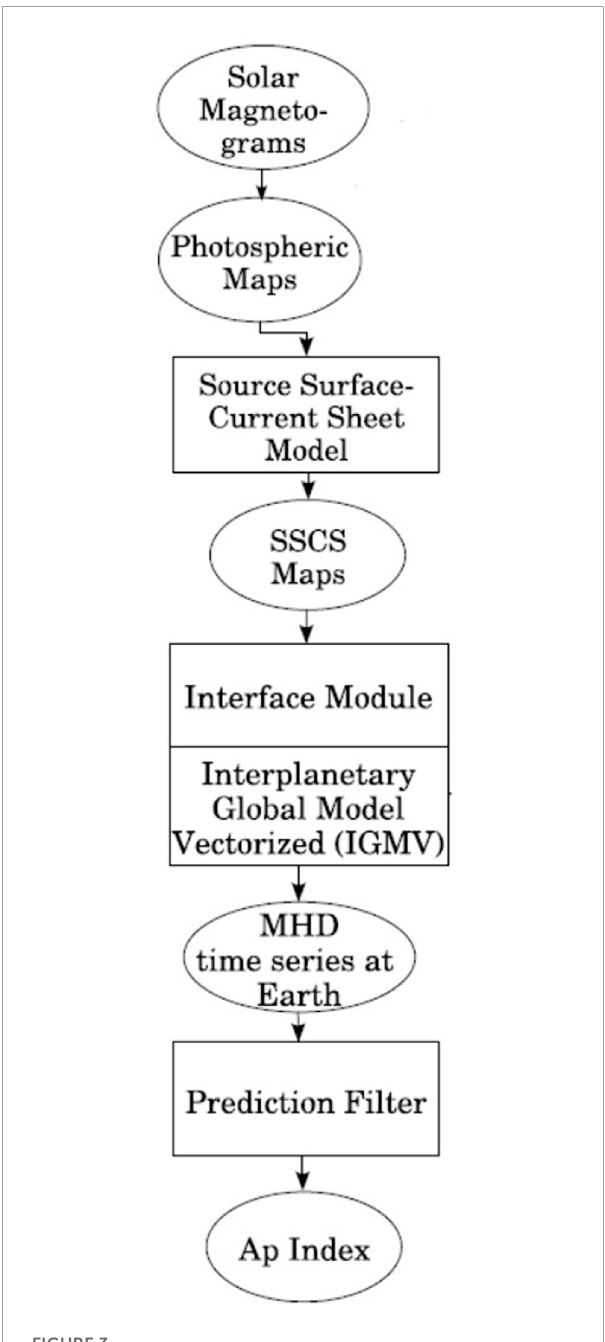
FIGURE 3 Block diagram of the HHMS (Detman et al.,